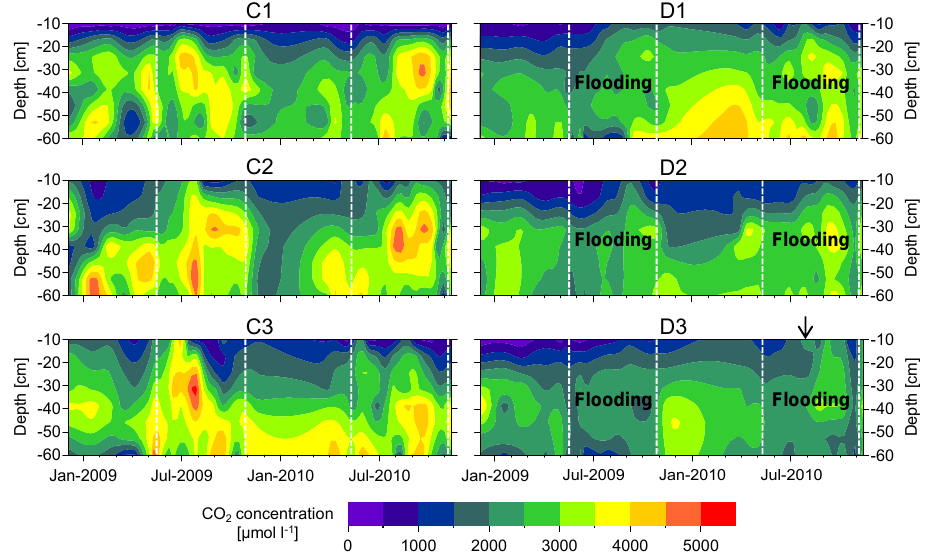
Fig. 6. Concentrations of dissolved CO 2 in pore water along soil profiles on control and flooded plots. Dashed white lines indicate start and end of the flooding periods during the growing seasons in 2009 and 2010. The arrow in D3 points to the date with an exceptional high soil CO 2 efflux due to interrupted flooding.